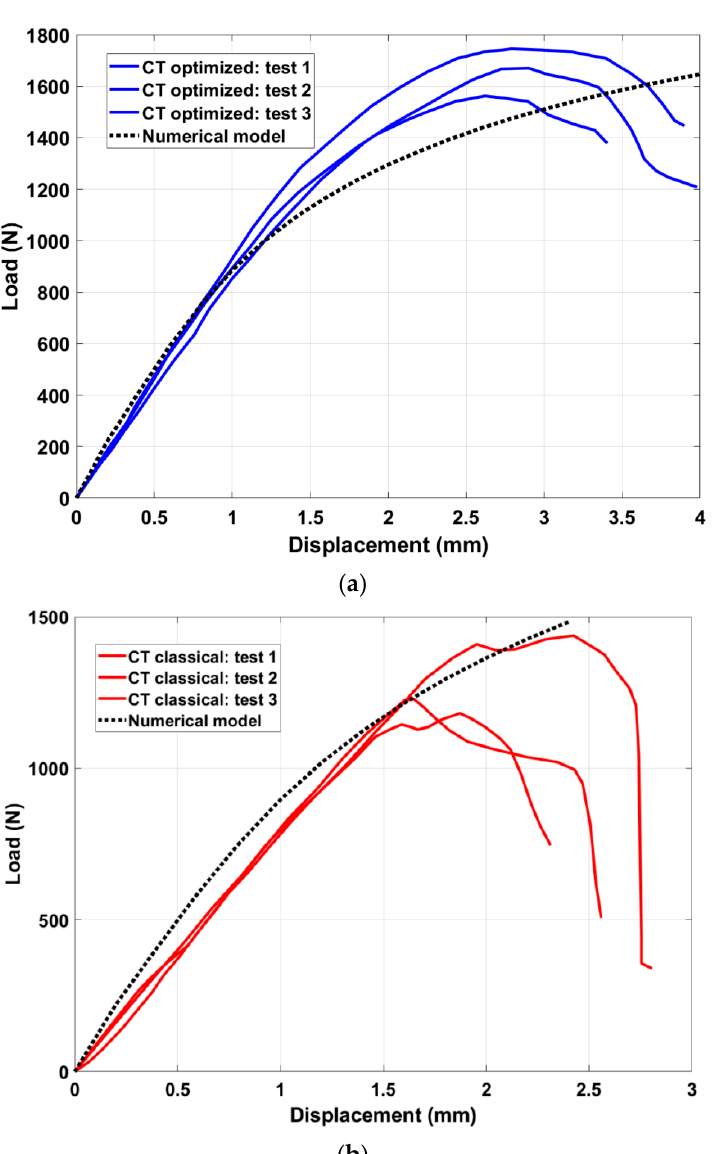
Figure 9. Load-displacement curves of CT test. Numerical model response is compared to experi- mental results. ( a ) Classical samples are printed with ± 45 ◦ and ( b ) Optimized samples; the filament is oriented according to the principal direction of the stress.